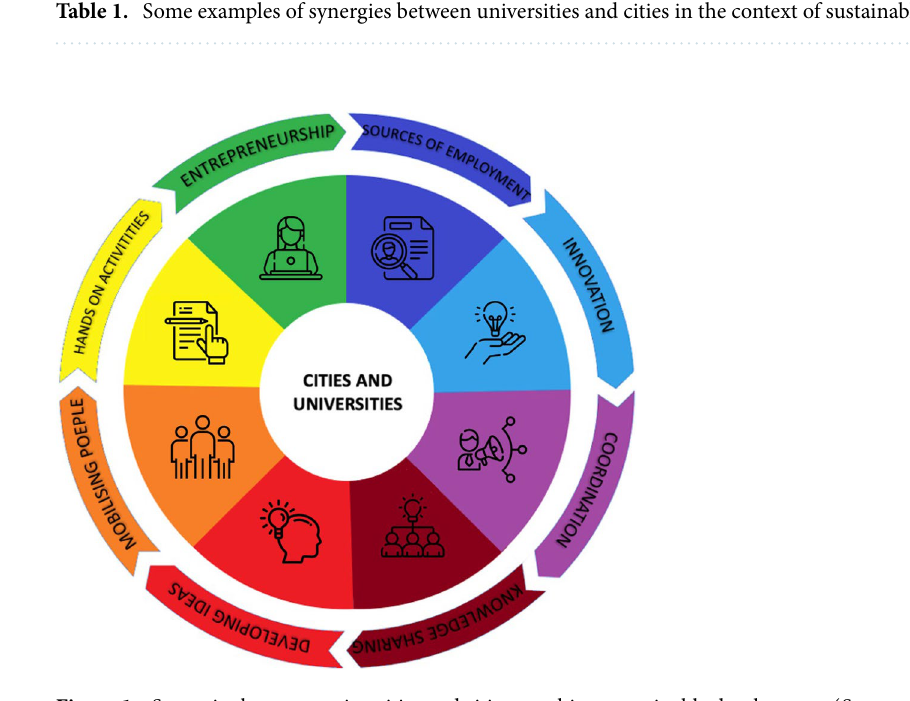
Figure 1. Synergies between universities and cities to achieve sustainable development ( Source prepared by the